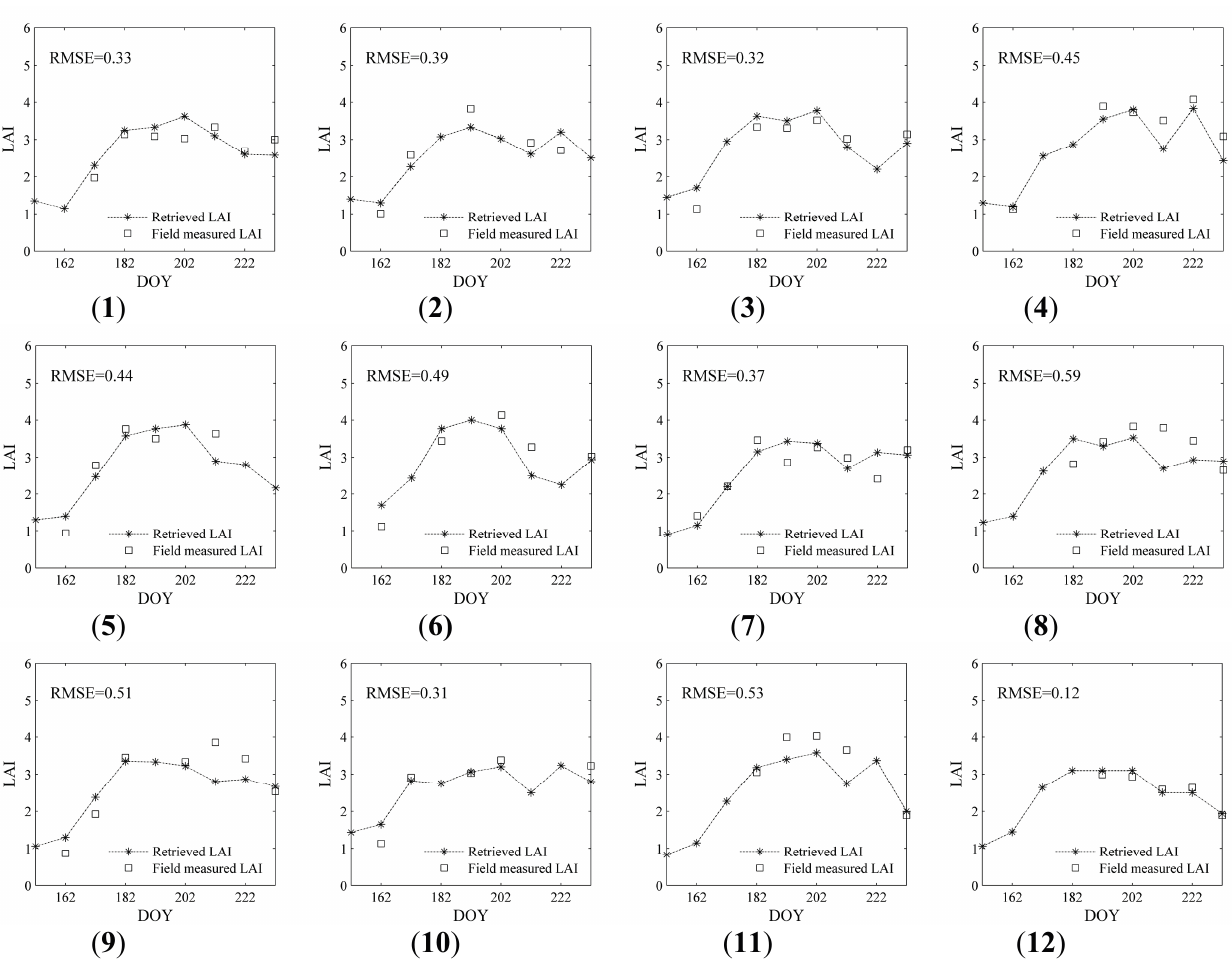
Figure 13. Comparison of the LAI multi-temporal inversion with 12 field measurements ( 1 – 12 ) by the WSN and LAI-2200 for